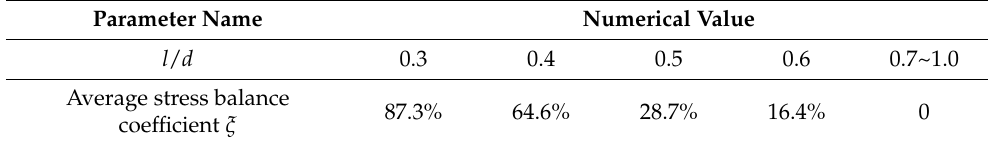
Table 3. Relationship of average stress balance coefficient of specimens and different l / d